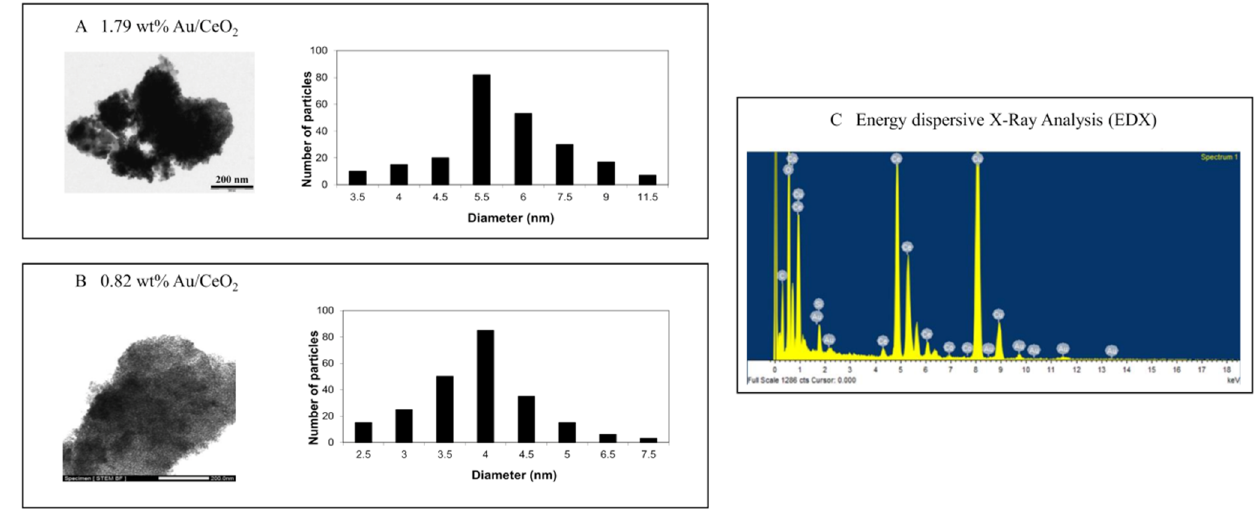
Figure 3. HR-STEM images and corresponding histograms of nanoparticle size distribution for ( A ) 1.79% AuCeO 2 with average diameter 6.04 nm and ( B ) 0.82 wt% Au/CeO 2 ( B ) with average diameter 3.94 nm. ( C ) Energy dispersive X-Ray analysis (EDX) demonstrating the presence in the particles of Au and Ce.